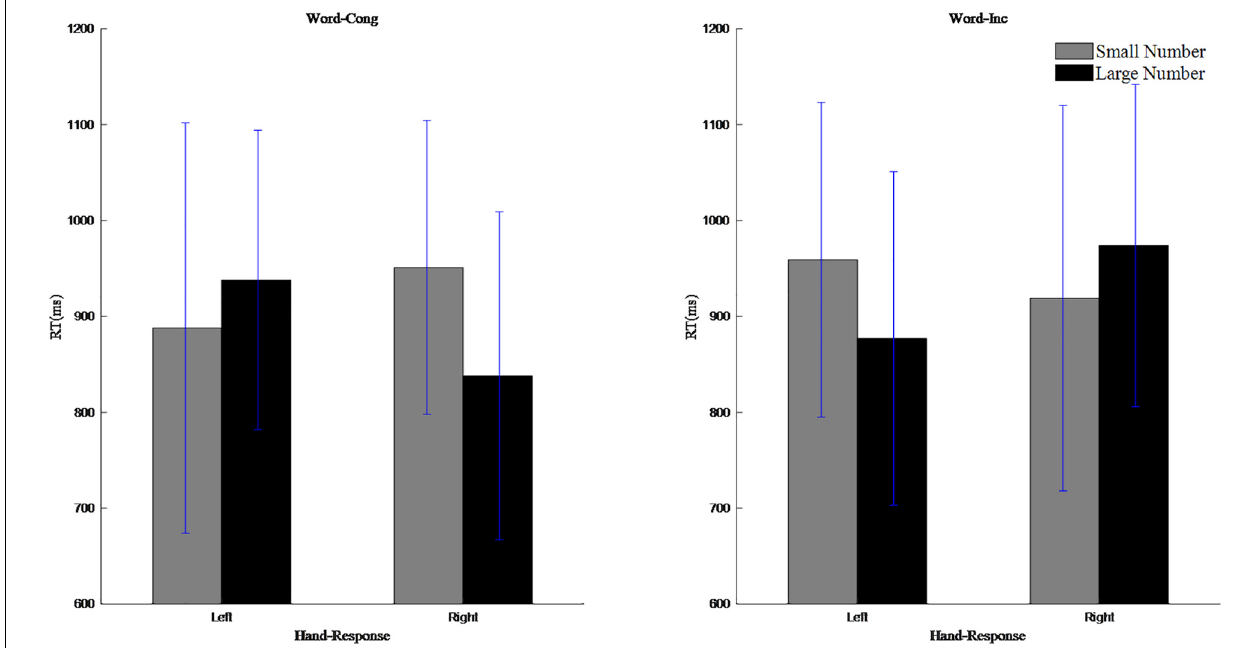
FIGURE 7 | The interaction between magnitude and reaction hand in magnitude judgment